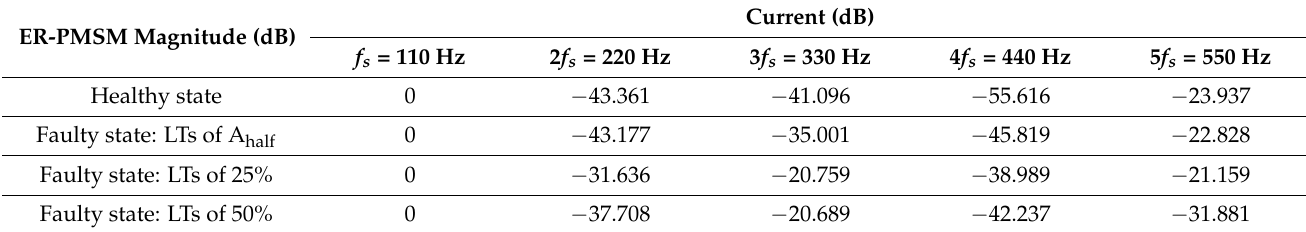
Table 3. Experimental magnitude of current components generated by the ER-PMSM at 8 Nm load and f s = 110